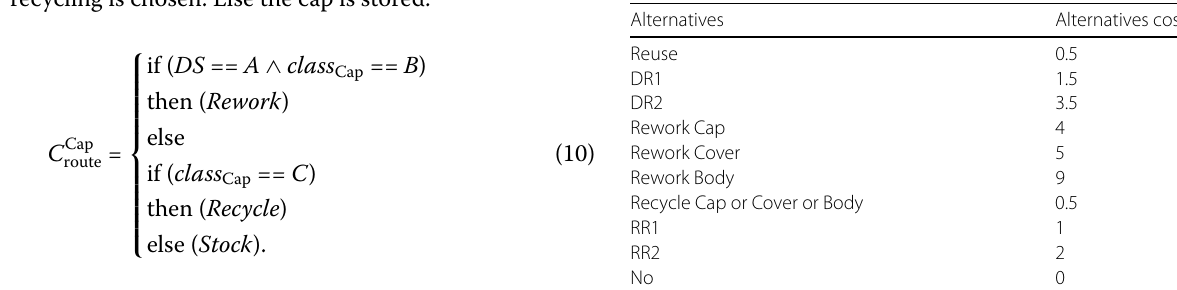
Table 4 Alternatives costs